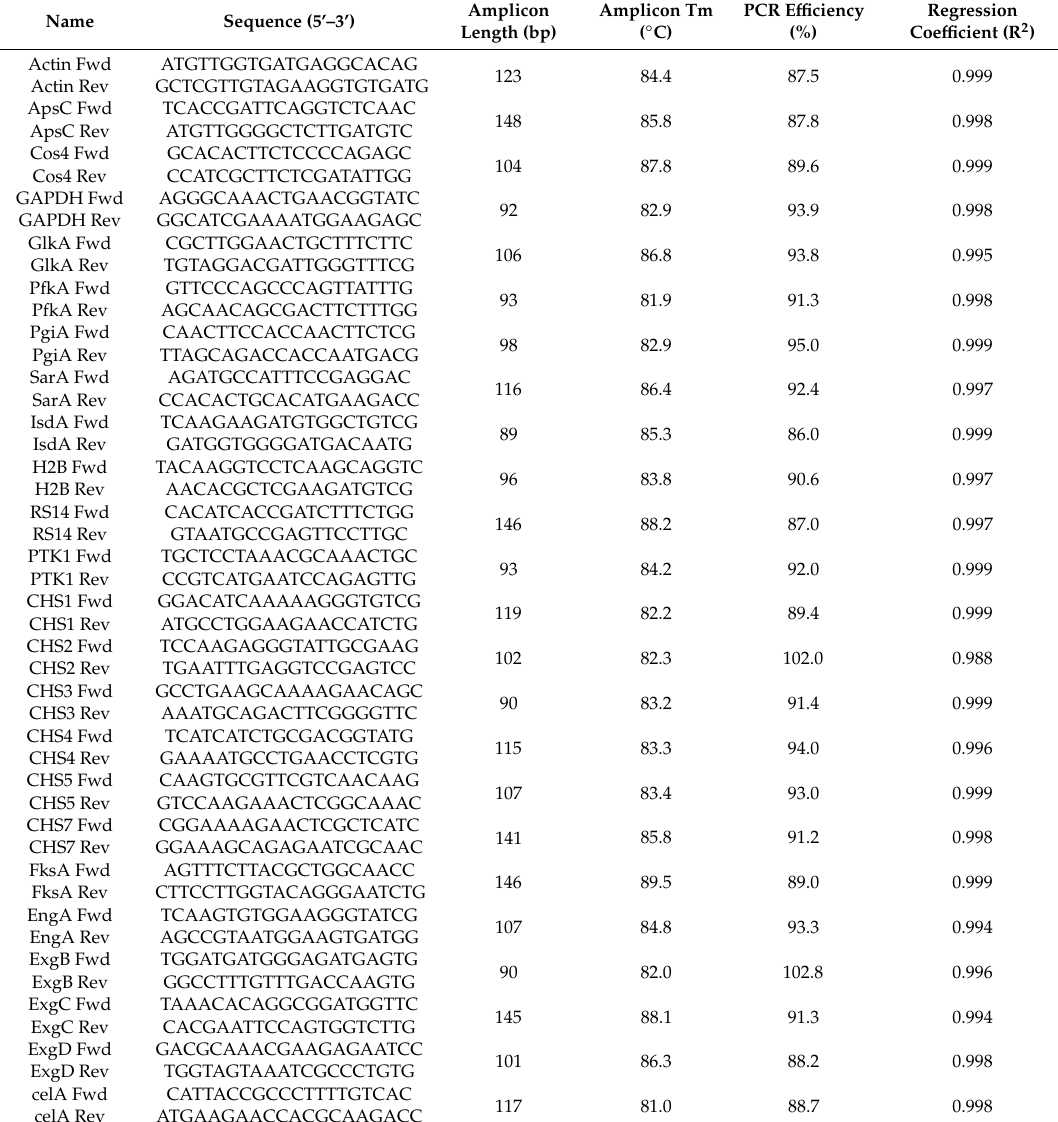
Table 2. Description of the primers used for the qPCR analyses with details on the sequences, amplicons’ length, Tm, amplification e ffi ciency and regression coe ffi